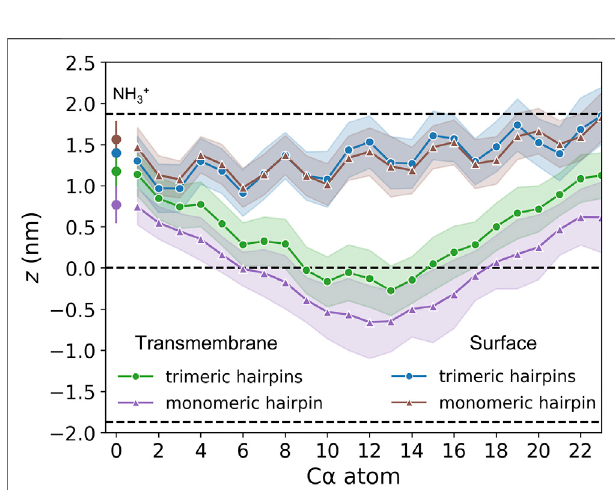
FIGURE5 | Insertion depthsof N-terminalamino group nitrogen and C α atoms of HAfp and one standard deviation (shadow). Dashed lines represent membrane surface (the maximum of phosphate atoms density, z ≈ 1.9 nm) and membrane midplane ( z = 0).